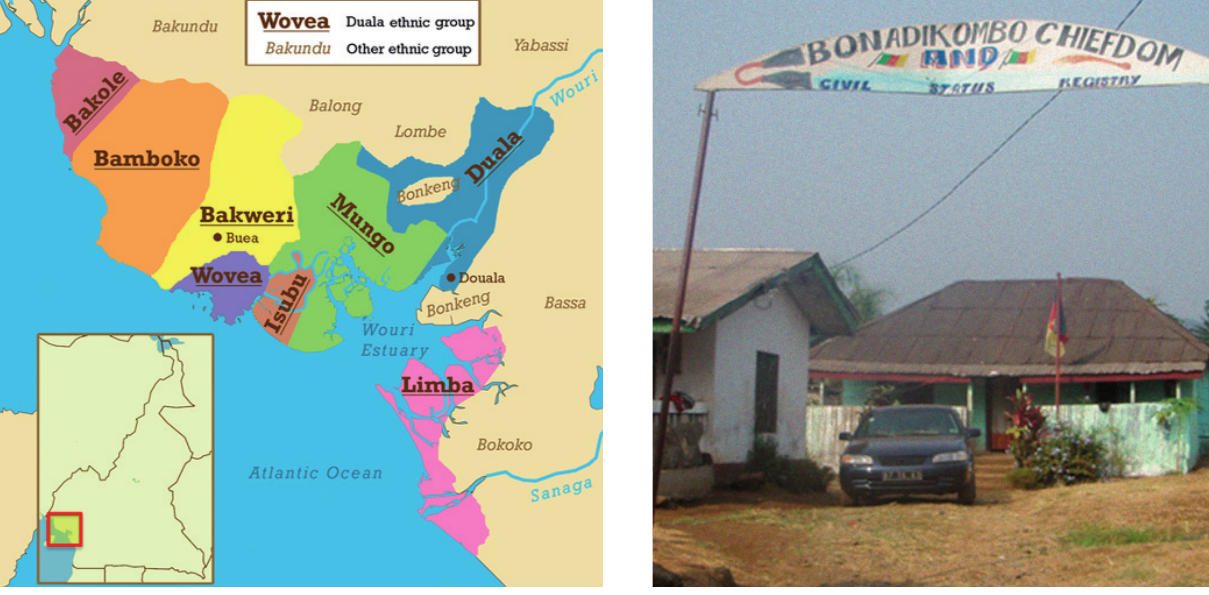
Figure 7. Ethno-linguistic group distribution of the southwest region of Cameroon (from http://en.wikipedia.org/wiki/Duala_people).